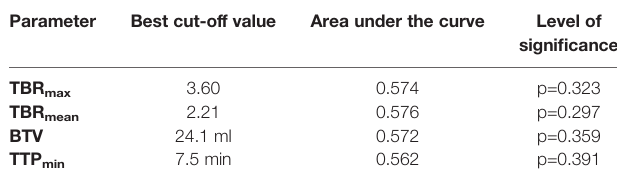
TABLE 2 | Diagnostic power of 18 F-FET PET for detection TERTp